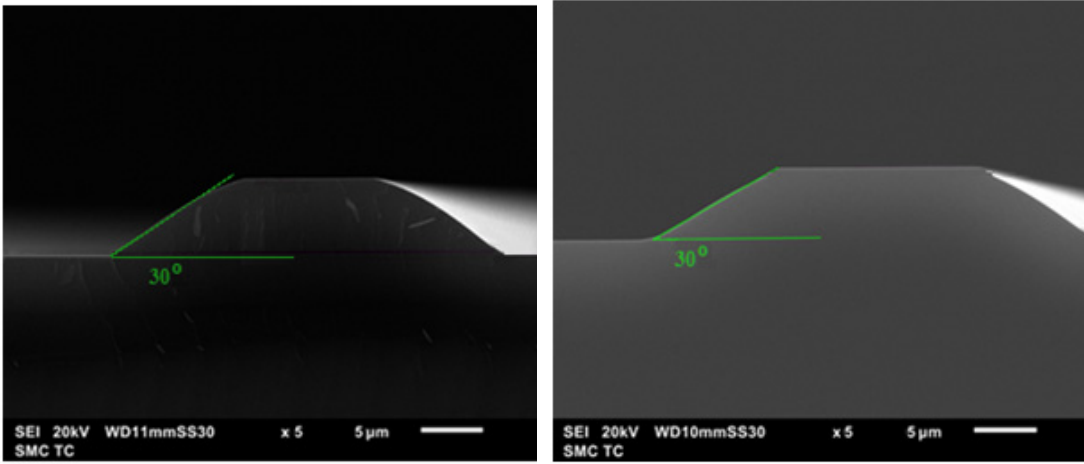
Figure 4. SEM images of the wedge-shaped profile of silicon etching.